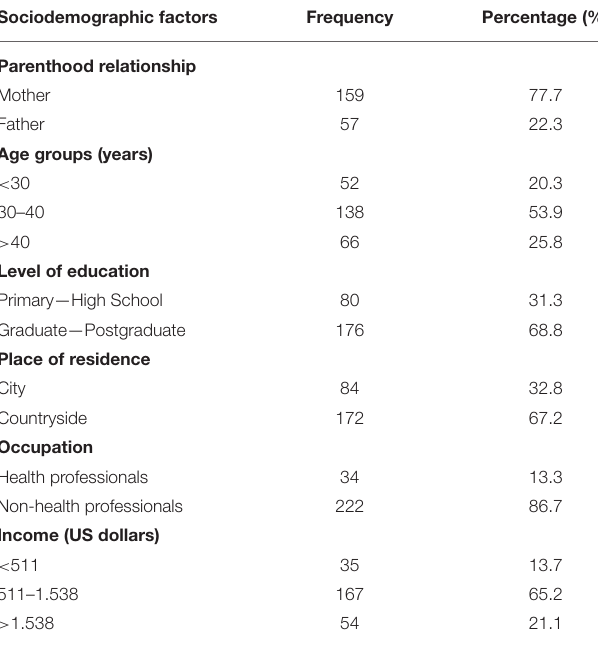
TABLE 3 | Comparison of the relationship between inadequate oral care and COVID-19 in children.